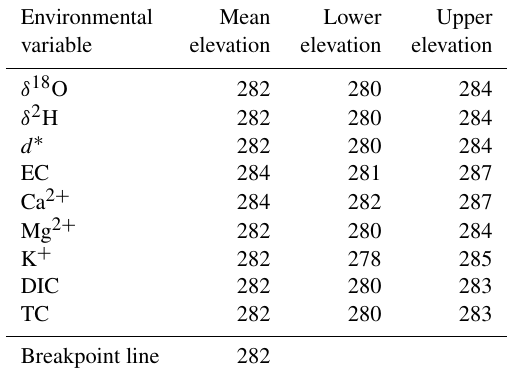
Table 1. Results showing significant break points in nine water- chemistry variables and lake elevation (lower and upper elevation ranges represent the standard